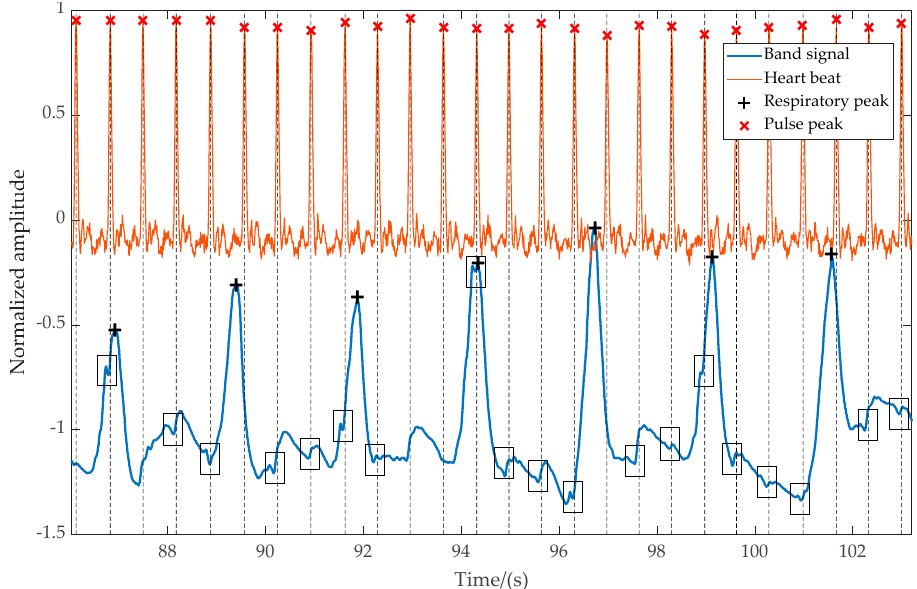
Figure 6. The magnitude of the respiration signal and pulse signal from the left-side band compared to heartbeat captured from a finger-worn pulse transducer. The heartbeat from the band is visible as small negative glitches, which represent the starting point of the pulse.